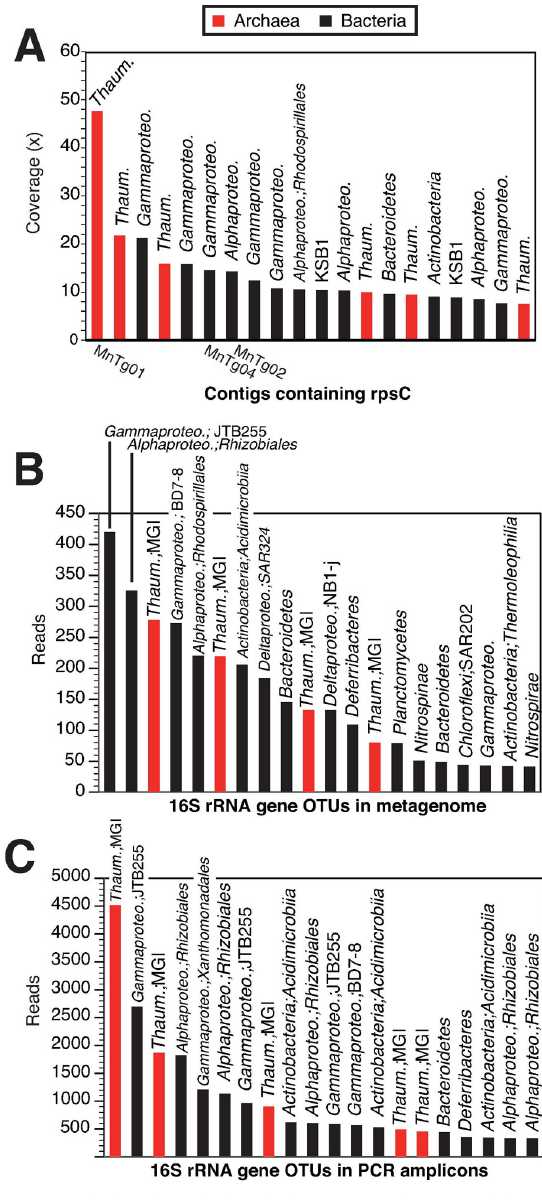
Fig 1. Rank abundant plot for phylogenetic marker genes. (A) Read coverage of contigs containing CDSs for RpsC, (B) read counts of 16S rRNA gene operational taxonomic units (OTUs) in the metagenome, and (C) read counts of 16S rRNA gene OTUs in the PCR amplicon obtained in the previous study [13]. Taxonomic affiliations for the CDSs for RpsC and 16S rRNA genes are indicated on the bars. The IDs of metagenome-assembled genomes (MAGs) are shown for the contigs containing CDSs identical to those of the MAGs. Red and black bars indicate archaeal and bacterial CDSs, respectively.